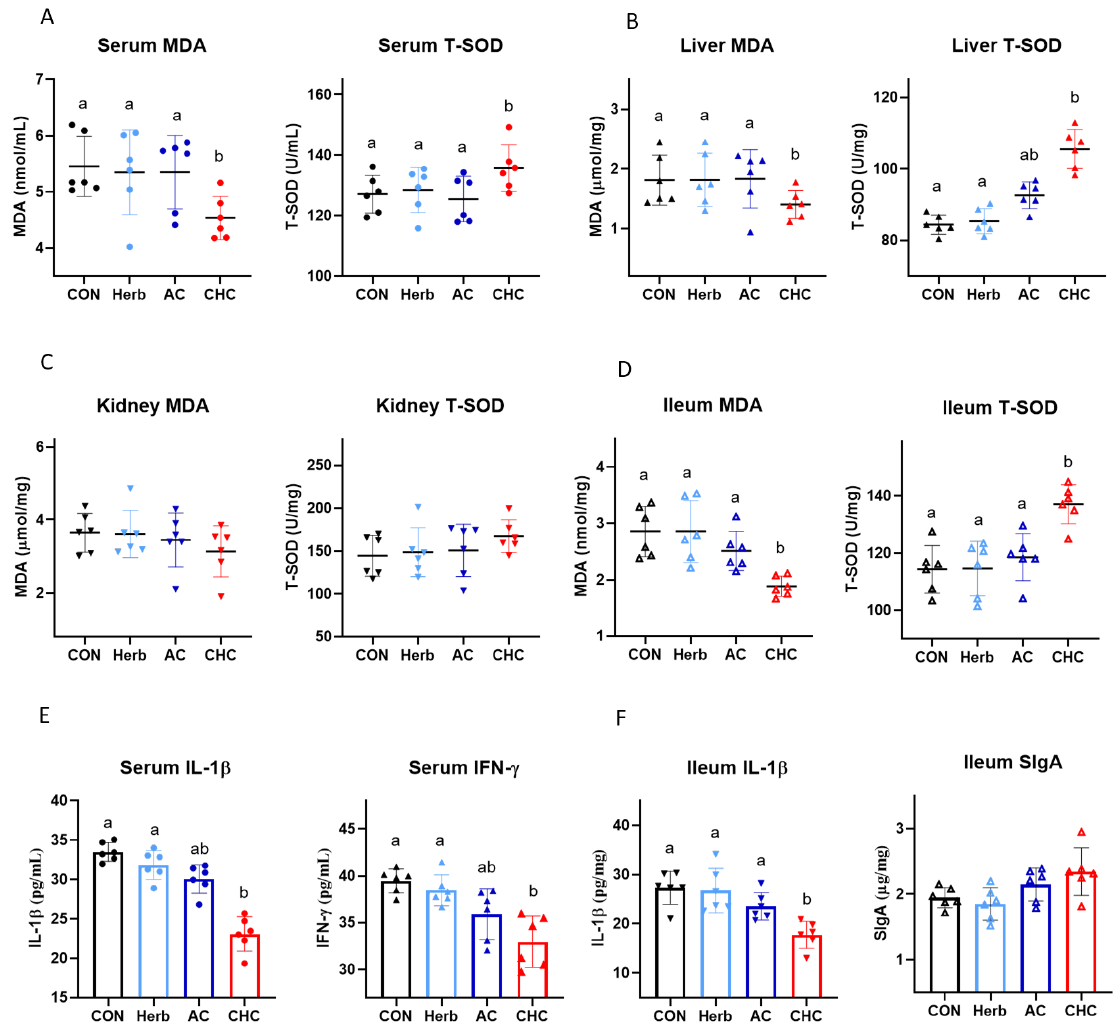
Figure 4. CHC effects on antioxidative and inflammatory indices in broilers. The indices include antioxidant indices (MDA and T-SOD) in the serum ( A ), liver ( B ), kidney ( C ), and ileum ( D ); anti- inflammatory and immune indices (IL-1 β , IFN- γ , and SIgA) in the serum ( E ) and ileum ( F ) on d 21. Broilers were fed with CON, Herb (25 mg/kg), AC (225 mg/kg), or CHC (250 mg/kg)-supplemented diets for 42 days. CON was corn-soybean basal die. Herb, herb extracts. AC, activated charcoal. One-way ANOVA was performed for statistical analysis. Bars with different letters indicate significant differences ( p < 0.01).